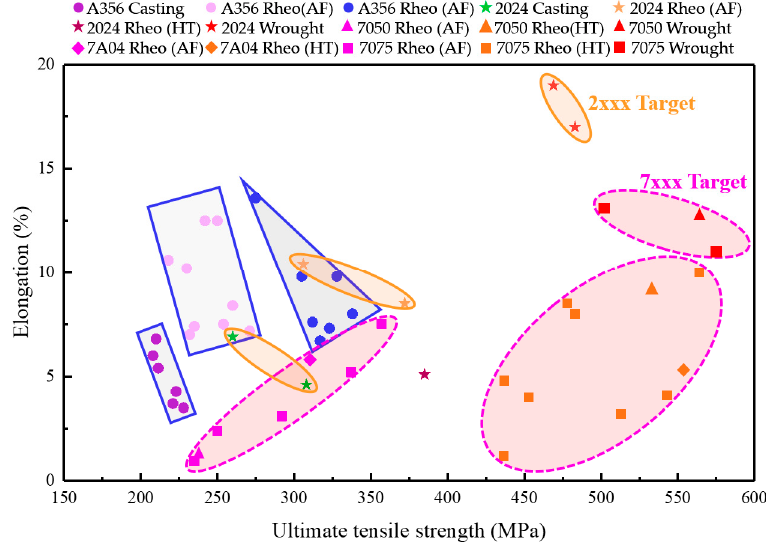
Figure 7. Comparation of tensile behaviors of some wrought Al alloys and A356 alloy fabricated